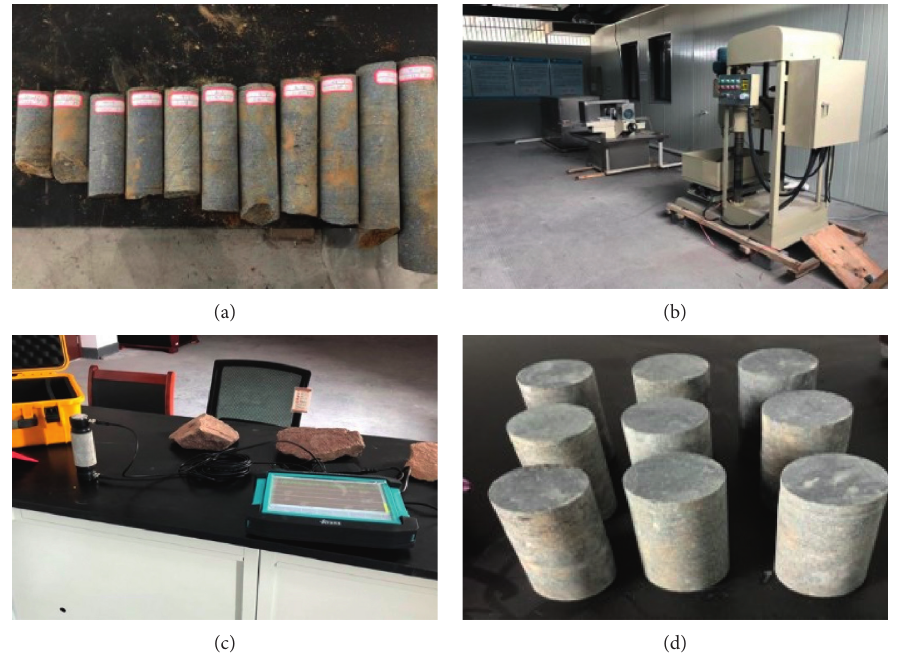
Figure 1: Sample preparation chart. (a) Initial sample; (b) rock sample cutting and polishing machine; (c) wave velocity measurement; (d) standard sample.